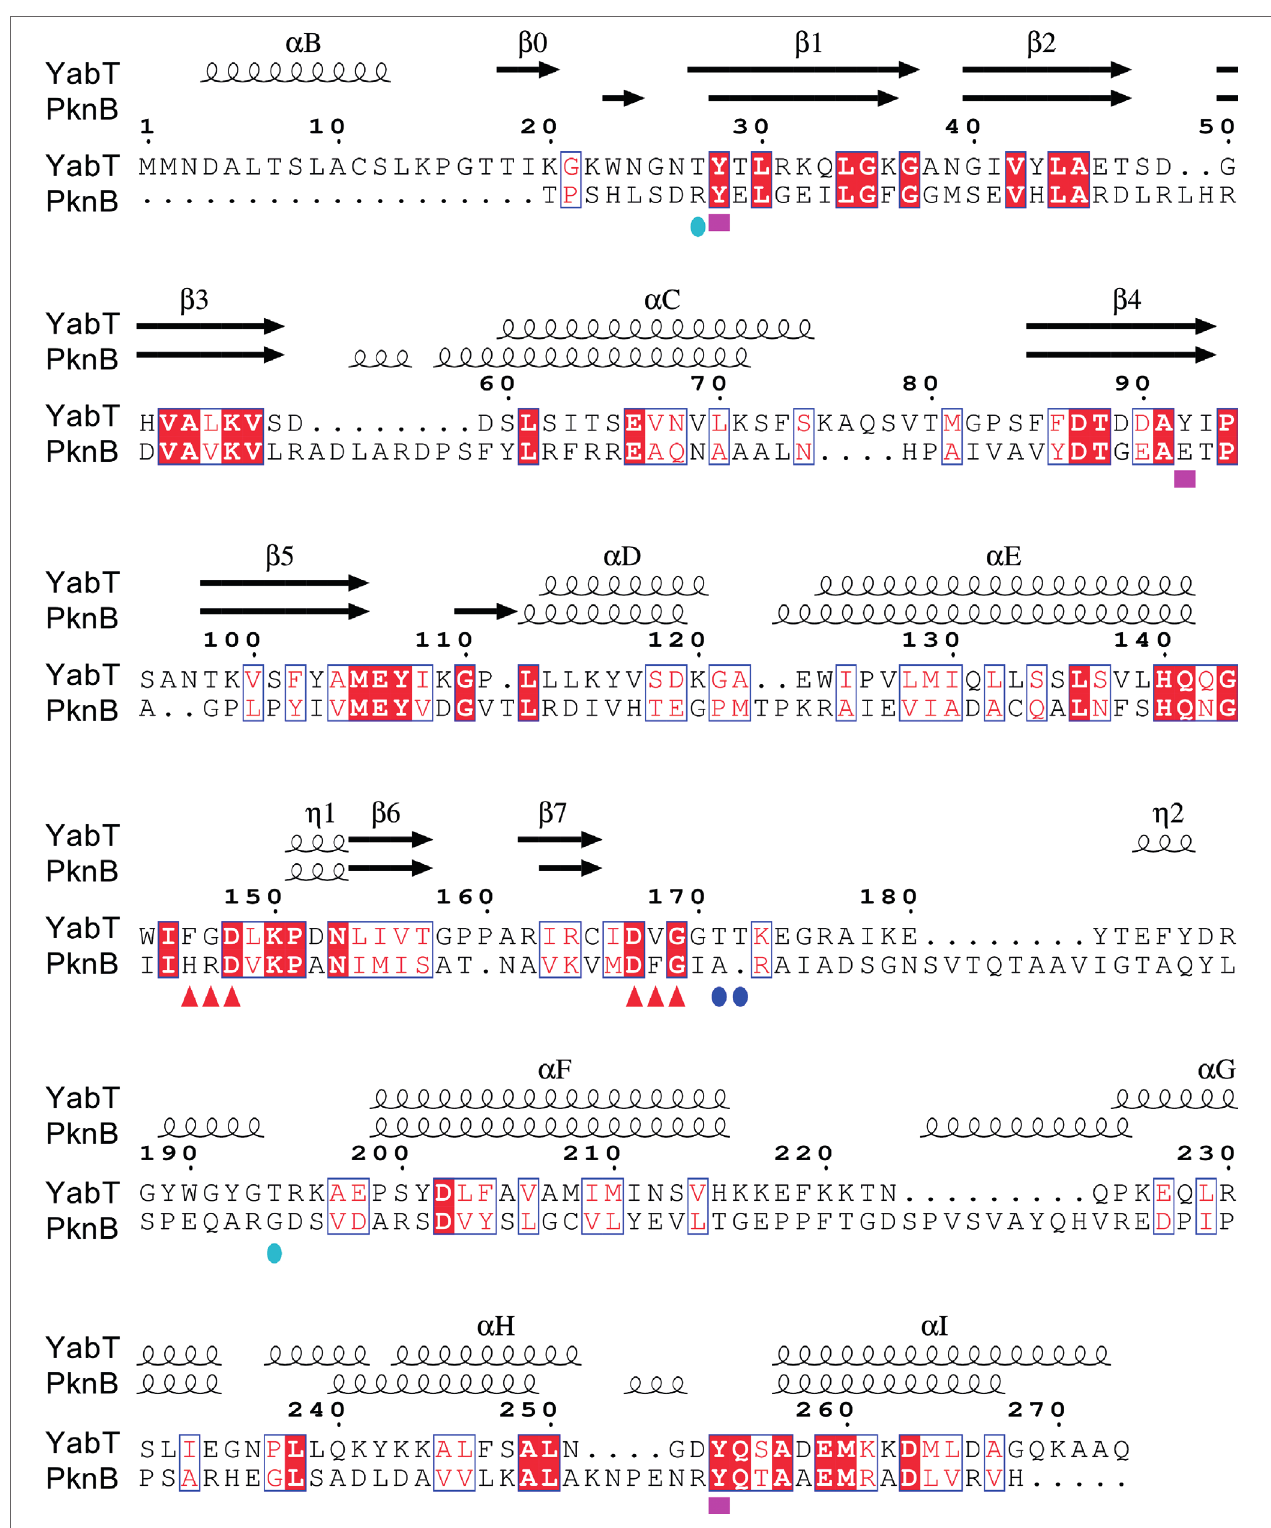
FIGURE 5 | Sequence alignment between YabT and its closest structural homolog PknB from Mycobacterium tuberculosis . The secondary structure elements are shown at the top, using the PDB entry 2FUM for PknB. YabT residues discussed in the text are highlighted by logos at the bottom of the alignment: F 146 G 147 D 148 and D 167 V 168 G 169 motifs as red triangles, regulatory autophosphorylation sites T171 and T172 as blue spheres, and PtkA phosphorylation sites Y28, Y92, and Y254 as magenta squares. Figure prepared using ESPript (http://espript.ibcp.fr) (Robert and Gouet,